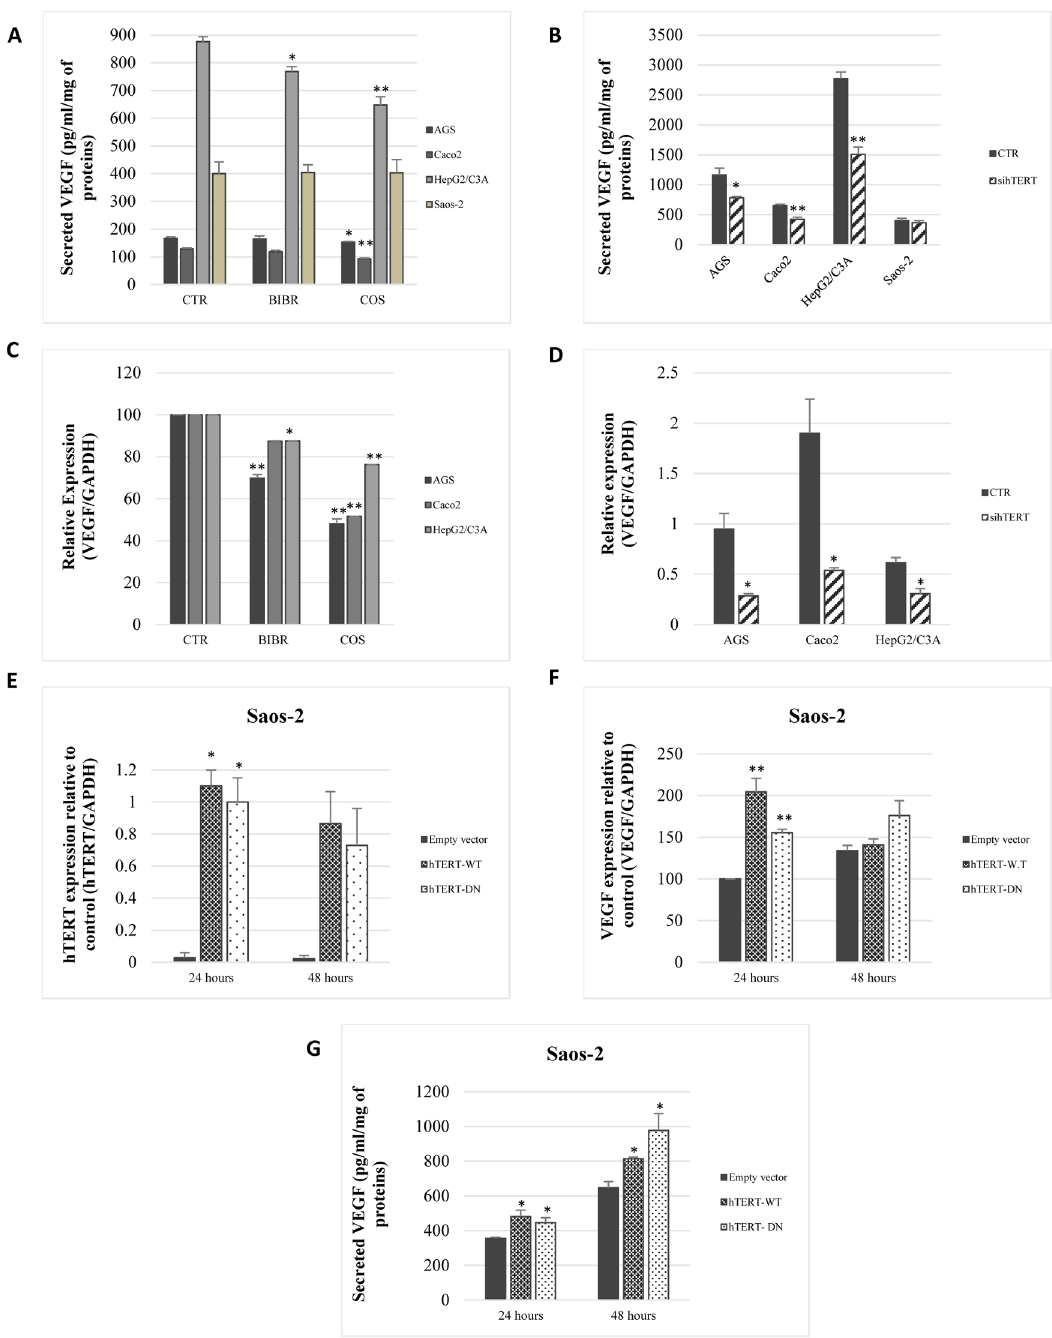
Fig 1. Telomeraseregulates VEGF secretion and expression independently of telomerase activity. (A, B) VEGF secretion was assessedby ELISA followinga 48-h treatment with telomeraseinhibitors BIBR-1532 (10 μ M) and costunolide (10 μ M), and after 72 h of hTERT knockdown with siRNA. (C, D) Total RNAs were isolatedfrom the cells treated in (A), and VEGF expressionwas analyzedby real-time PCR with GAPDH as the internalcontrol. (E, F, G) Saos-2 cells were transientlytransfected with an empty vector, hTERT-WT, and hTERT-DN. hTERT (E) and VEGF expression (F) were quantifiedby real-time PCR. Secreted VEGF was quantified by ELISA (G). Results were expressedas the mean ± SD from a minimumof three